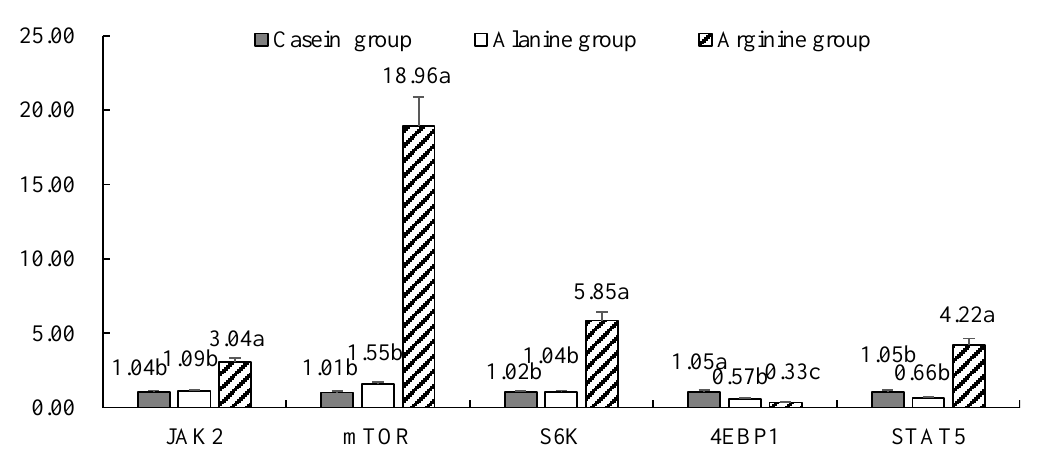
Figure 1. Expression of functional genes regulating casein yield in cow mammary tissue in the in vivo trial. Values with lower case letters were not different ( P > 0.05). Values with different lower case letters differed ( P < 0.05). JAK2 = Janus kinase 2; mTOR = Mechanistic target of rapamycin; S6K = Ribosomal protein S6 kinase; 4EBP1 = eIF4E-binding protein 1; STAT5 = Signal transducer and activator of transcription 5.